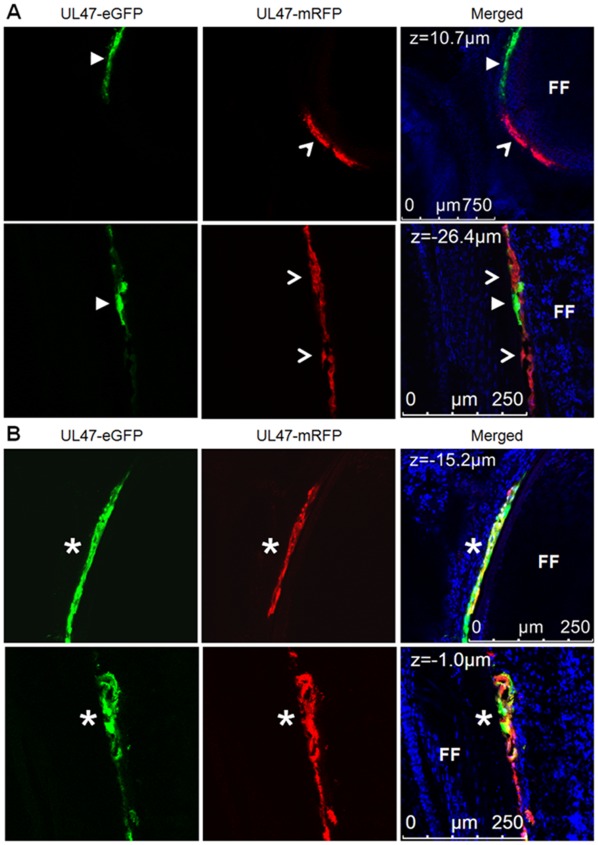
Summary of coinfected feather follicles and dual infected FFE cells at high magnification.Skin/feather tissues were collected from chickens coinfected with vUL47-eGFP and vUL47mRFP and examined using an SP5 LSCM system from Leica Microsystems, Inc. at ×200 (A, top panel) or ×400 (A, bottom panel and B). Hoechst 33342 stain was used to stain nuclei (blue). Single Z-stack images are shown with the depth indicated in the upper left of each image. Arrowheads (◂), open arrowheads (<), and asterisks (*) indicate single and dual infected cells as in Fig. 2. Superinfection inhibition can be seen in (A), while dual infection of FFE cells with both viruses replicating can be seen in (B). Feather follicles (FF) are indicated.